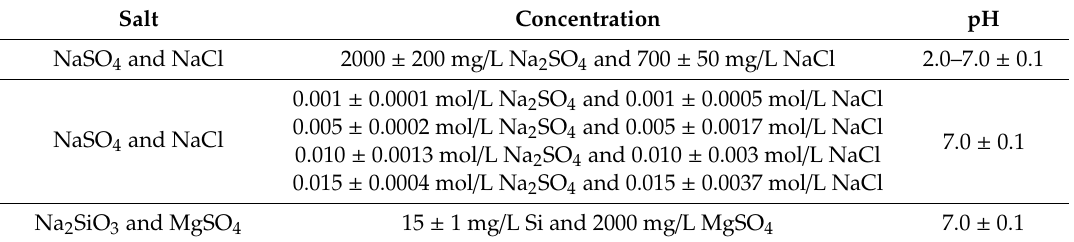
Table 2. Mixed salt solution feed